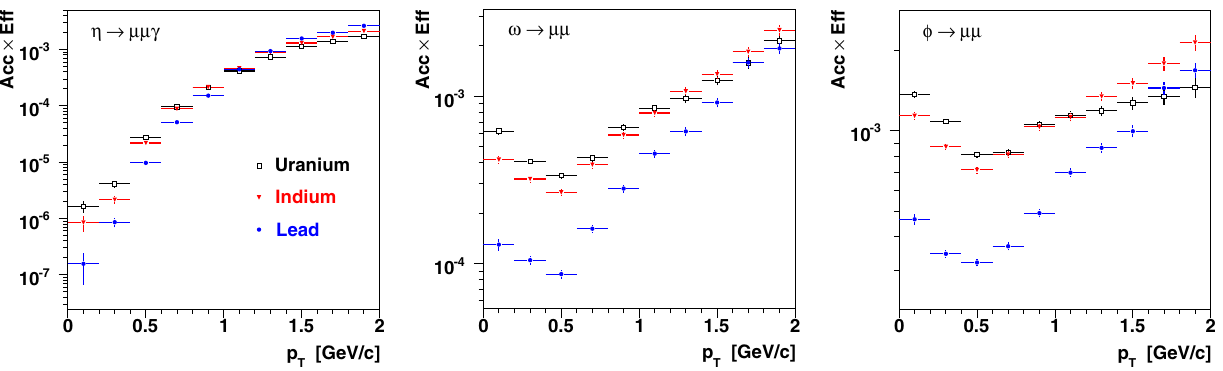
Fig. 1 Acceptance × reconstruction efficiency vs p T for the Uranium, Indium and Lead targets, for the three processes η → μ + μ − γ , ω → μ + μ − and φ → μ + μ −